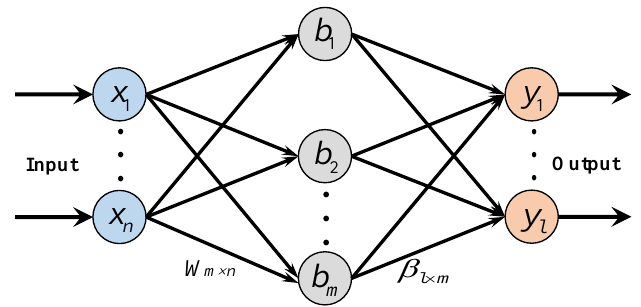
Figure 4. The architecture of the ELM model.